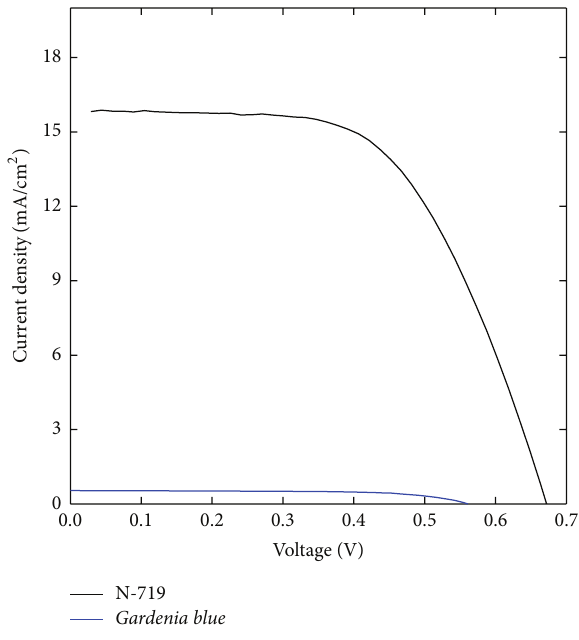
Figure 10: I-V curves of Gardenia blue and